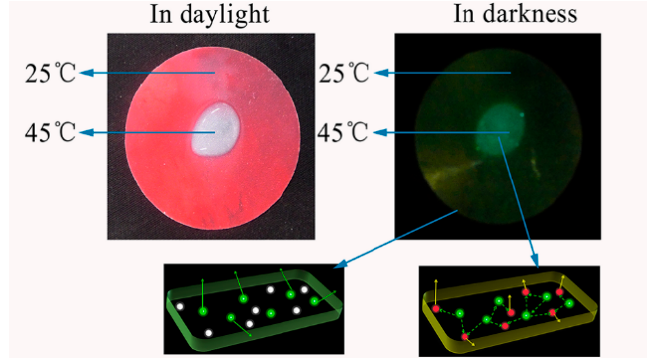
Figure 9. The digital image of thermochromic luminous phenomena and thermosensitive process together with luminescence model in darkness [70].